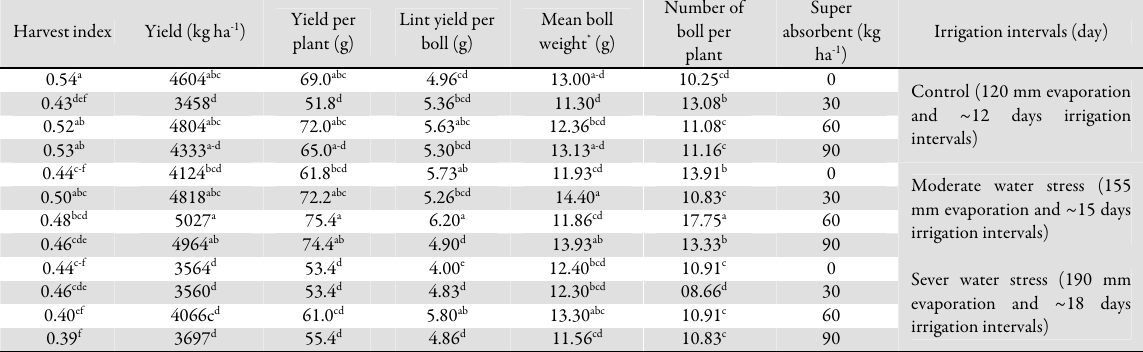
342 Table 6. Means comparison for interaction effects of irrigation management and SAP application on reproductive growth indices of cotton Harvest index Yield (kg ha -1 )